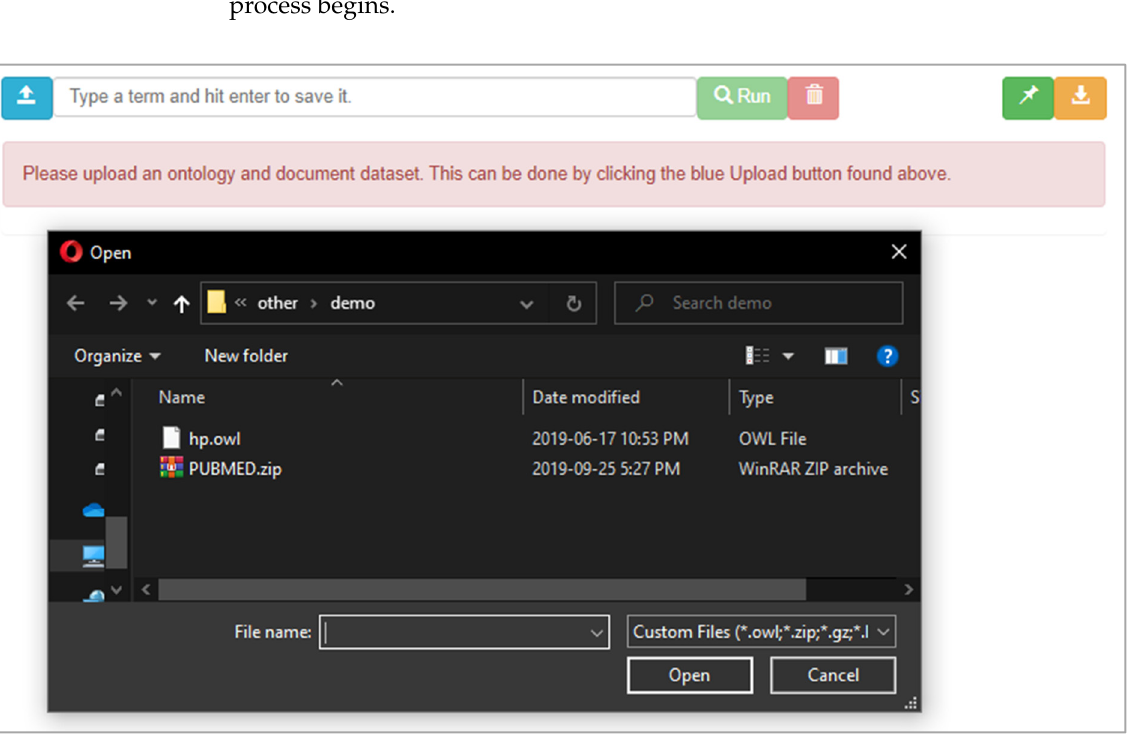
Figure 8. Selecting a document set and ontology file for upload.